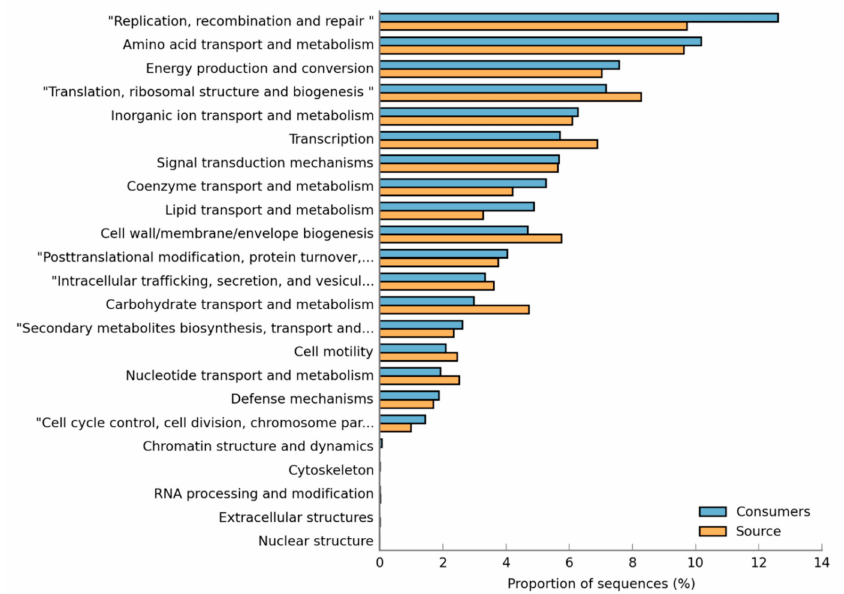
Figure 7. Relative percentage bar plot of metabolic pathways associated with genes identified in consumer and source biofilm samples.